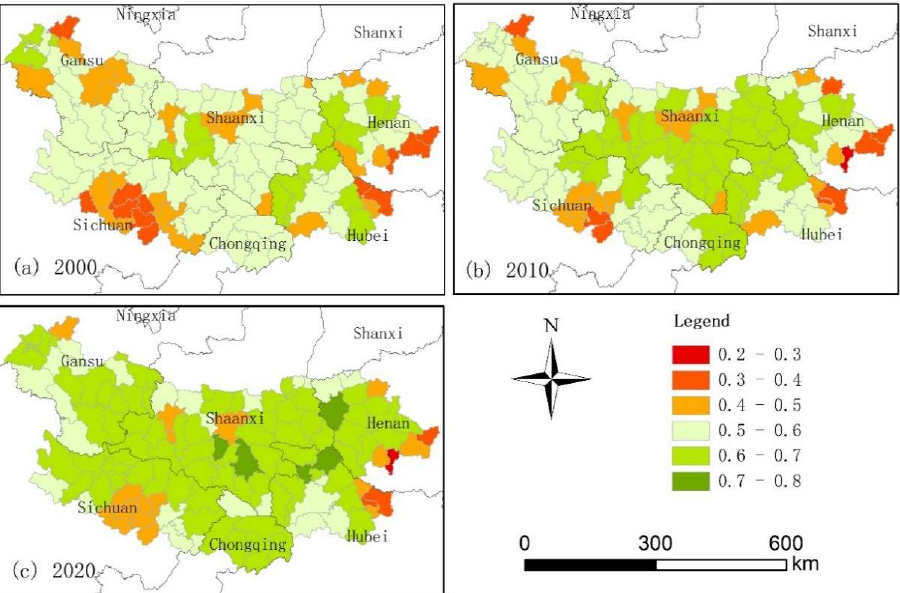
Figure 4. Spatial distribution of comprehensive ecosystem health index at the county level in the Qinling-Daba Mountains from 2000 to 2020.